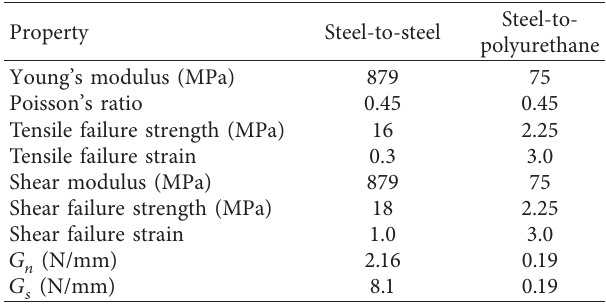
Table 2: Mechanical properties of adhesives measured at strain rate 1.5 × 10 − 4 (1/s).